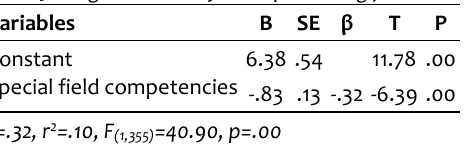
Table 5. Regression analysis on predicting feared teacher possible selves Variables B SE β T P Constant Special field